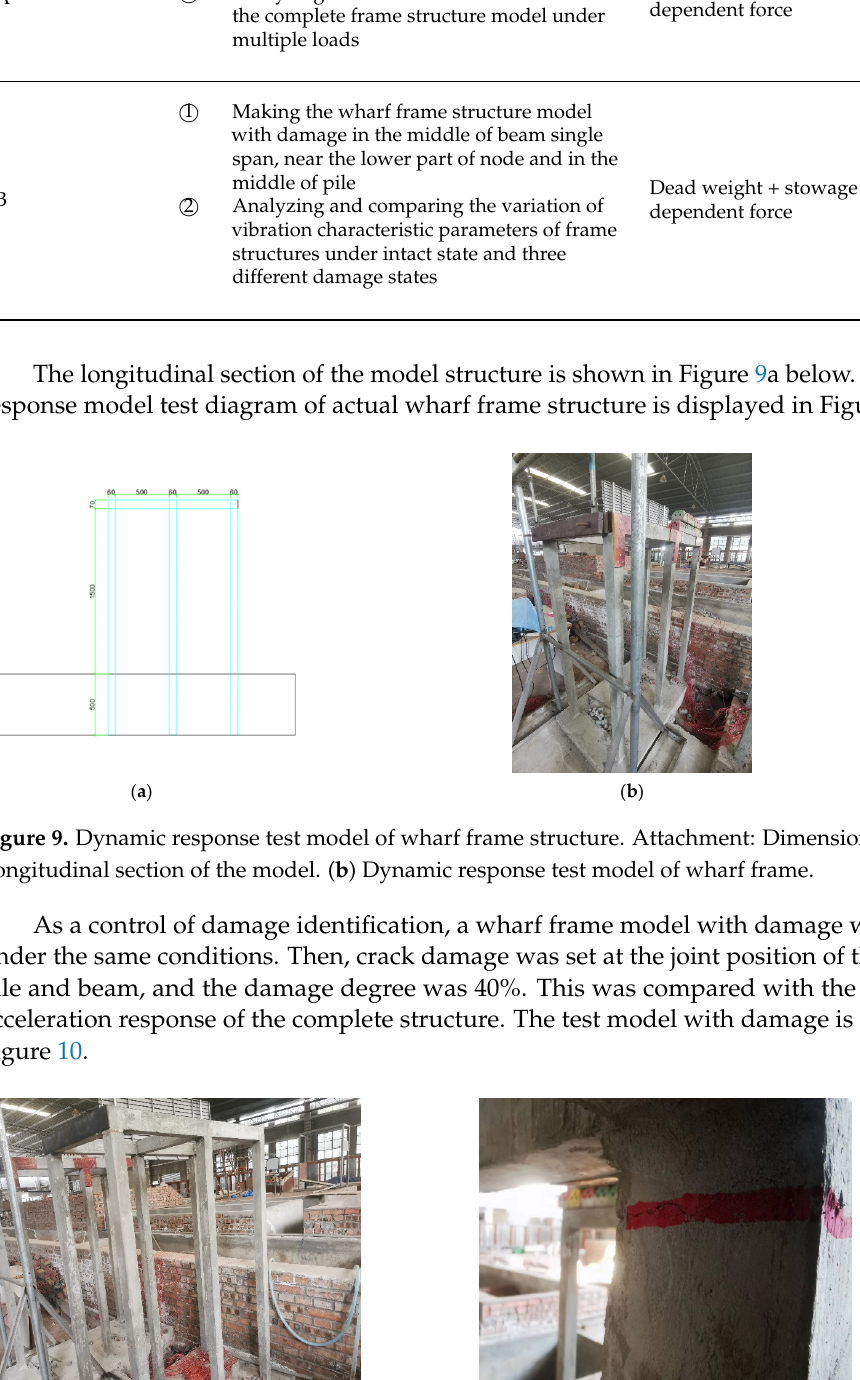
Figure 10. Test model of wharf frame structure with damage. ( a ) Test model of wharf frame with damage. ( b ) Damaged part of model.